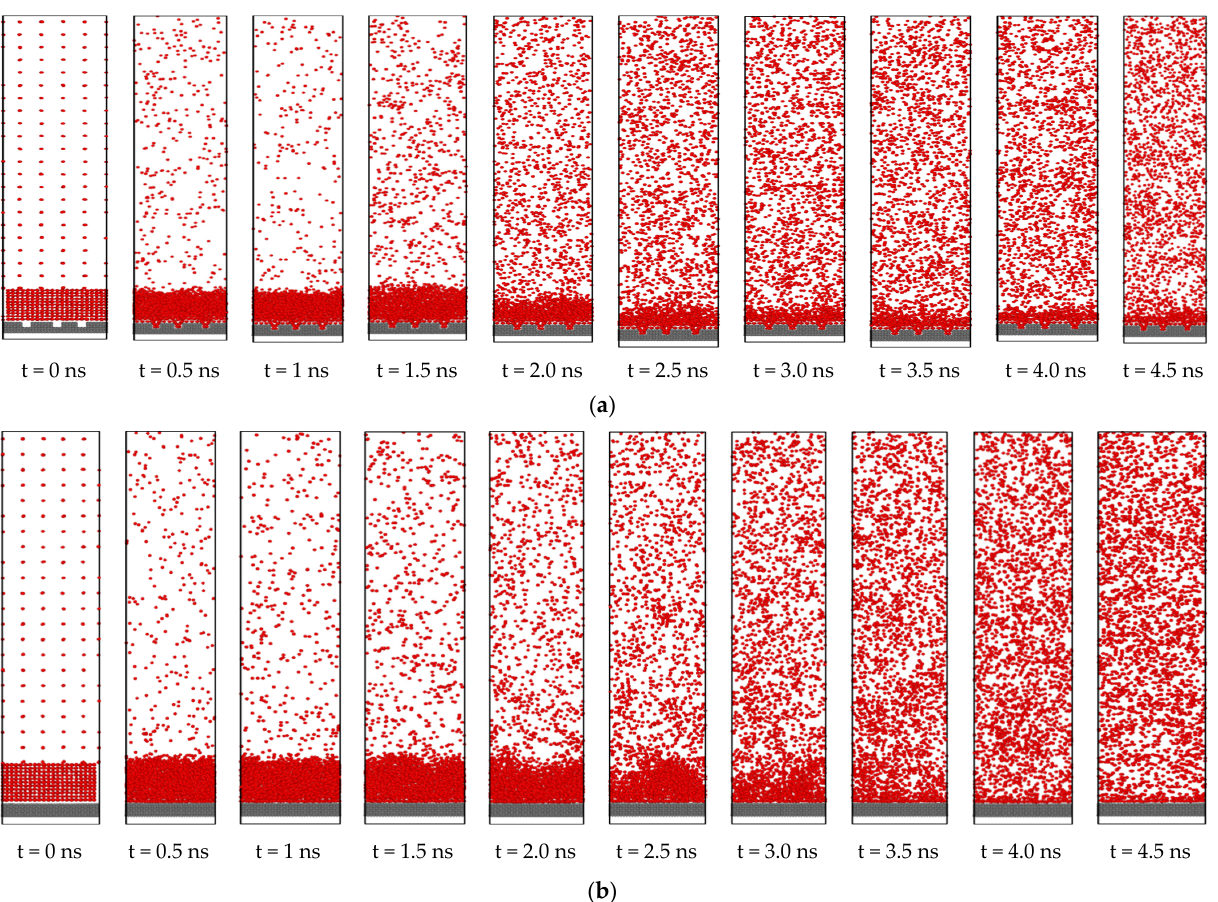
Figure 14. Snapshots from the simulation domain ( x – y plane) for ( a ) surface having nano slots, ( b ) smooth surface.